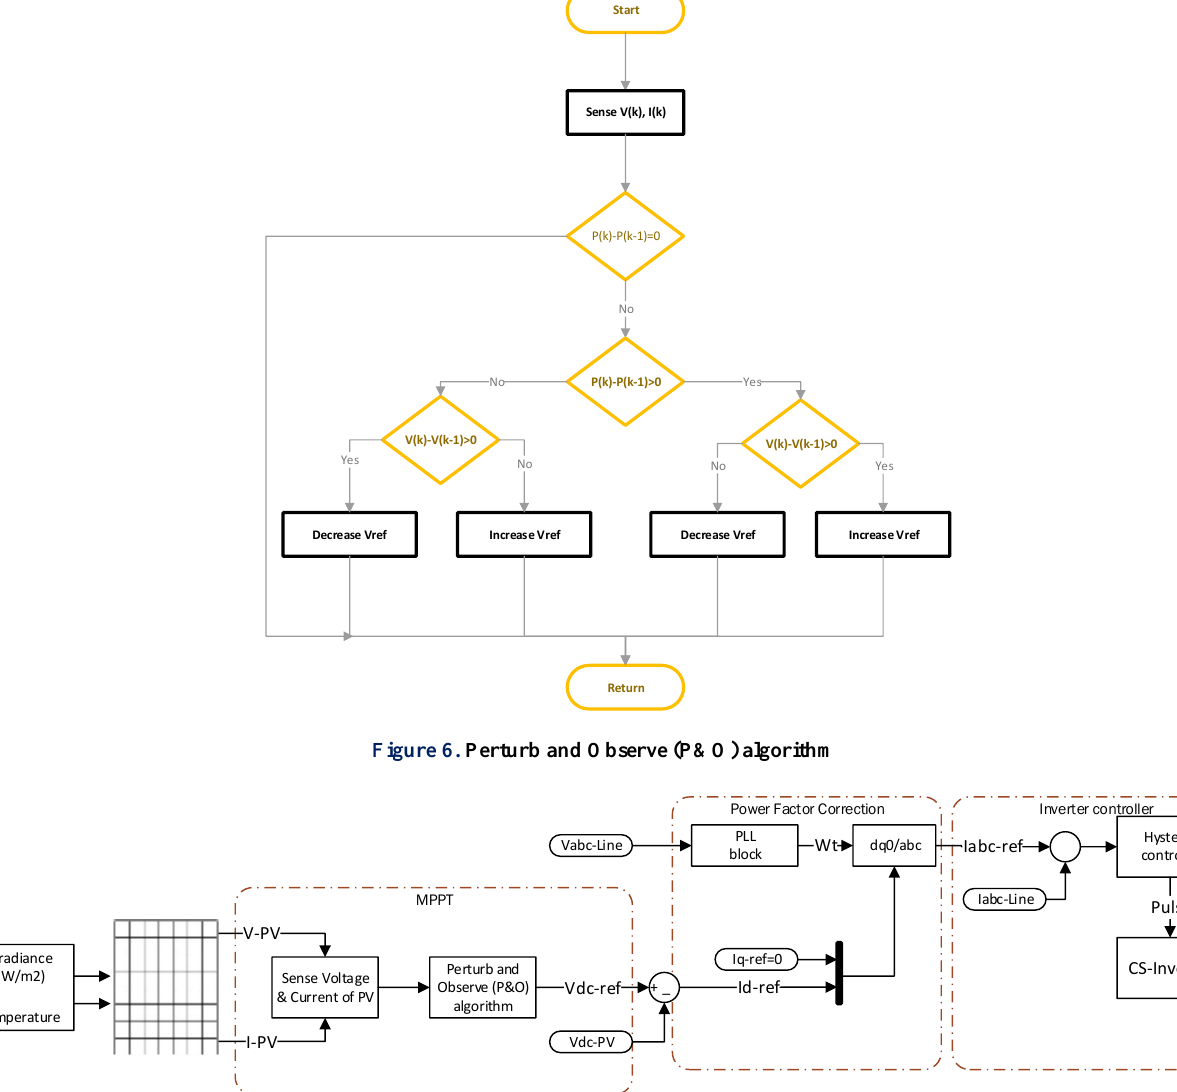
Figure 7. Block diagram of control